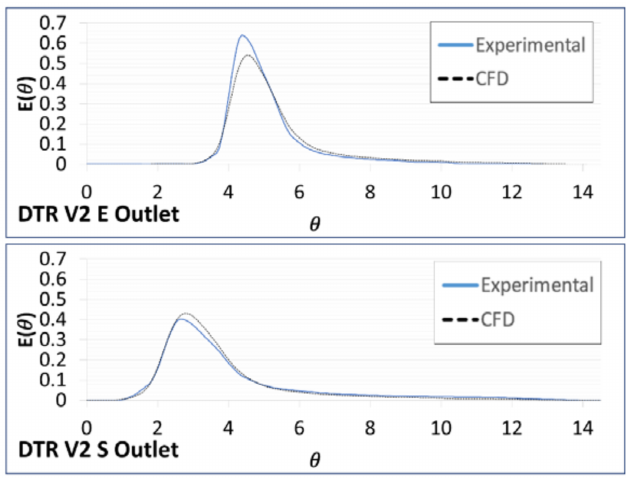
Figure 8. Residence Time Distribution (RTD) curves for V1.